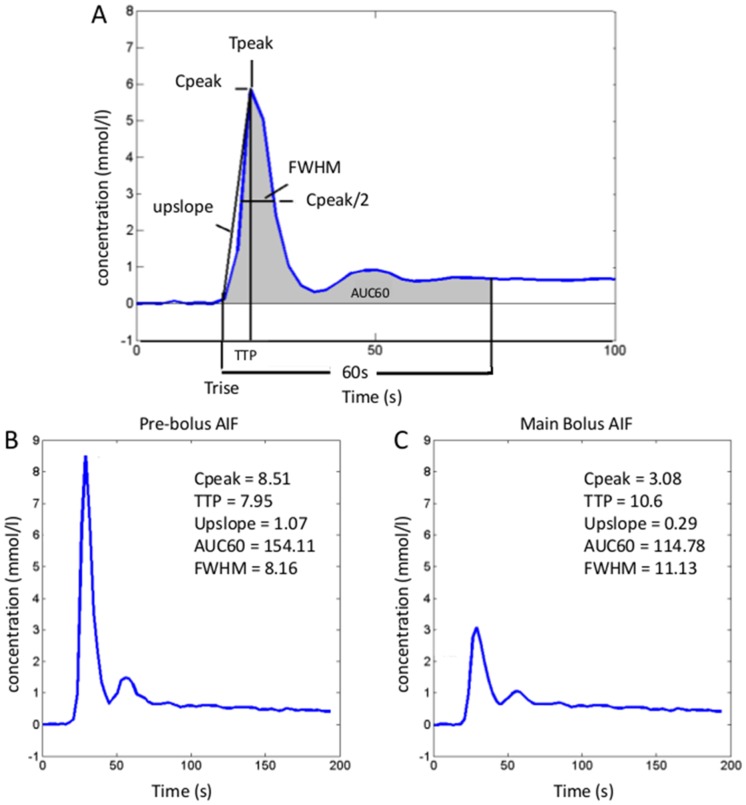
Diagram depicting calculated AIF (arterial input function) parameters (A).An example is shown in a 67-year-old patient with HCV (same patient as in Fig. 1). Pre-bolus AIF (B) and main bolus AIF (C). Pre-bolus AIF demonstrates higher peak concentration, upslope and AUC60, shorter TTP and smaller FWHM (values are given on the figures).